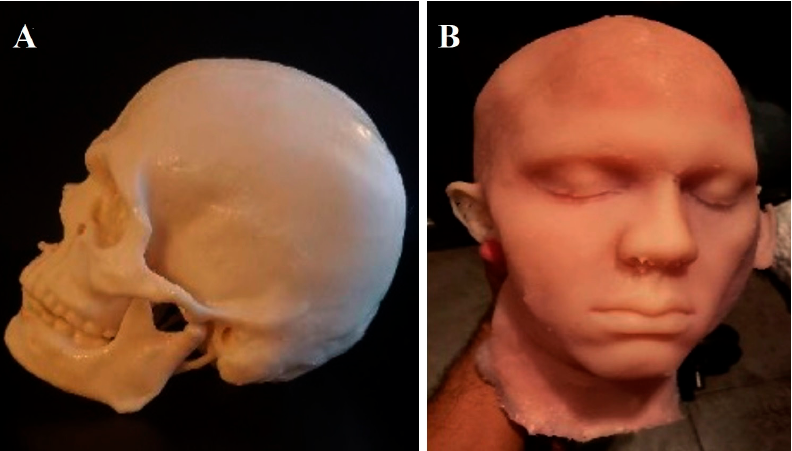
Figure 3. A negative model of the original head is created ( A ). The silicone head looks like an exact copy of the original model ( B ).